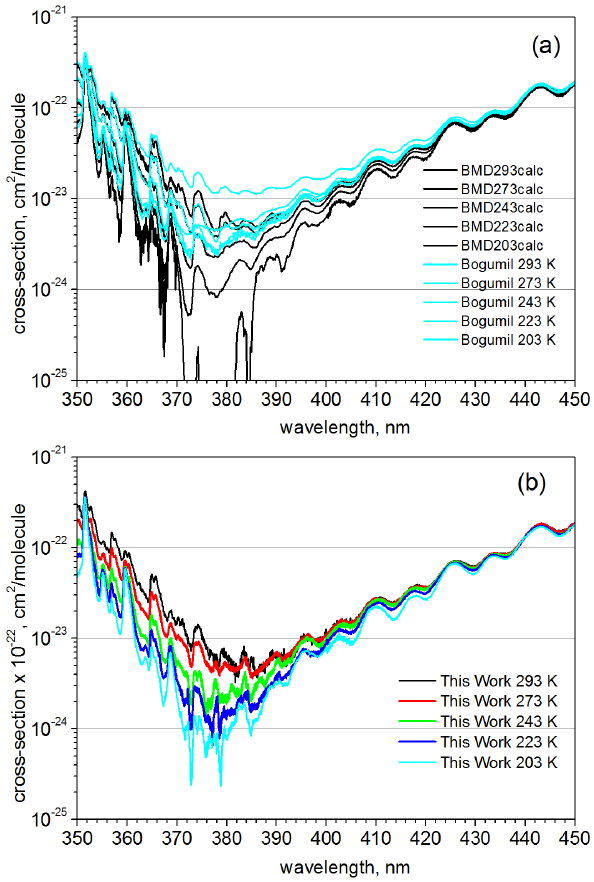
Fig. 7. Ozone cross-sections at 350–450nm at different tempera- tures: (a) Bogumil et al. (2003) and BMD; (b) this work.